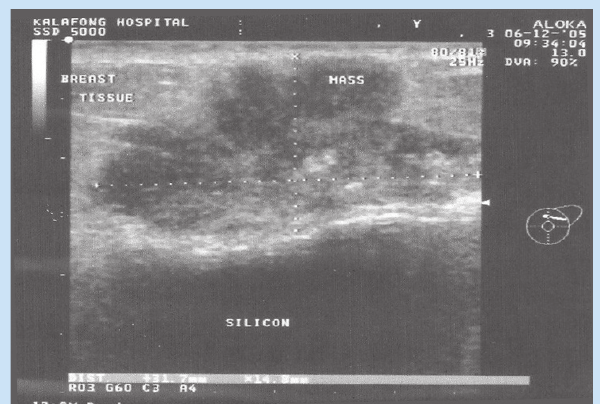
Fig. 1. Inhomogeneous poorly outlined vascular mass in the left upper outer quadrant at two o’clock. Note the microcalcifications. This was the mass that was